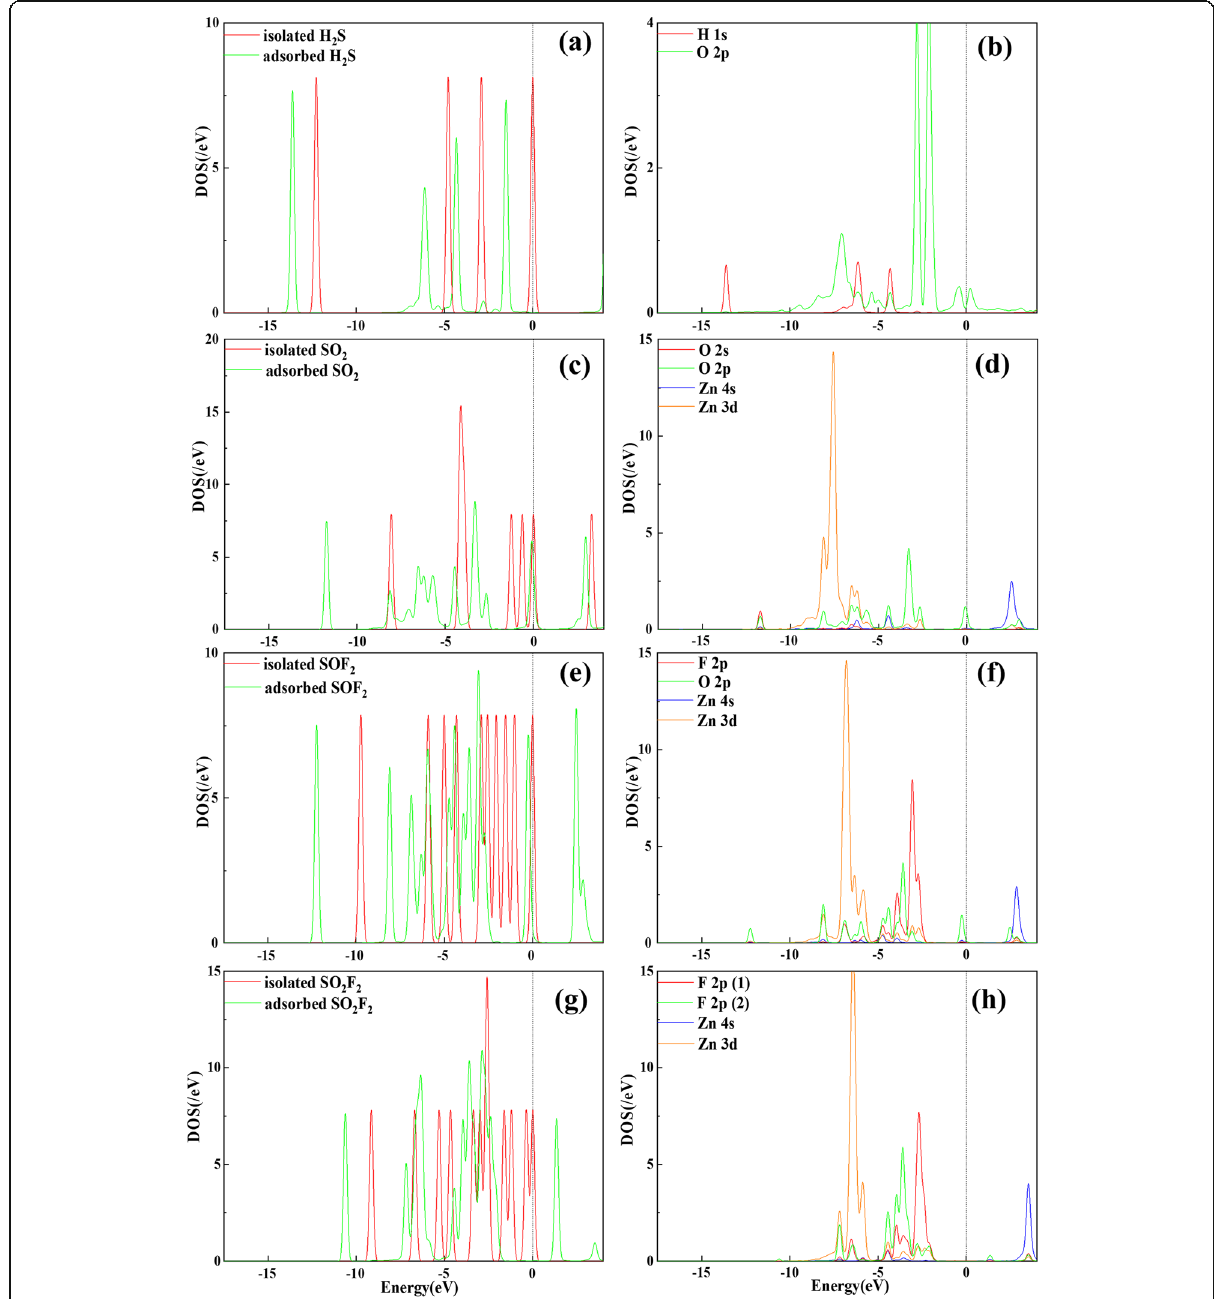
Fig. 6 DOS and PDOS of the gas molecule adsorbed on ZnO-C 3 N monolayer. a , b H 2 S system. c , d SO 2 system. e , f SOF 2 system. g , h SO 2 F 2